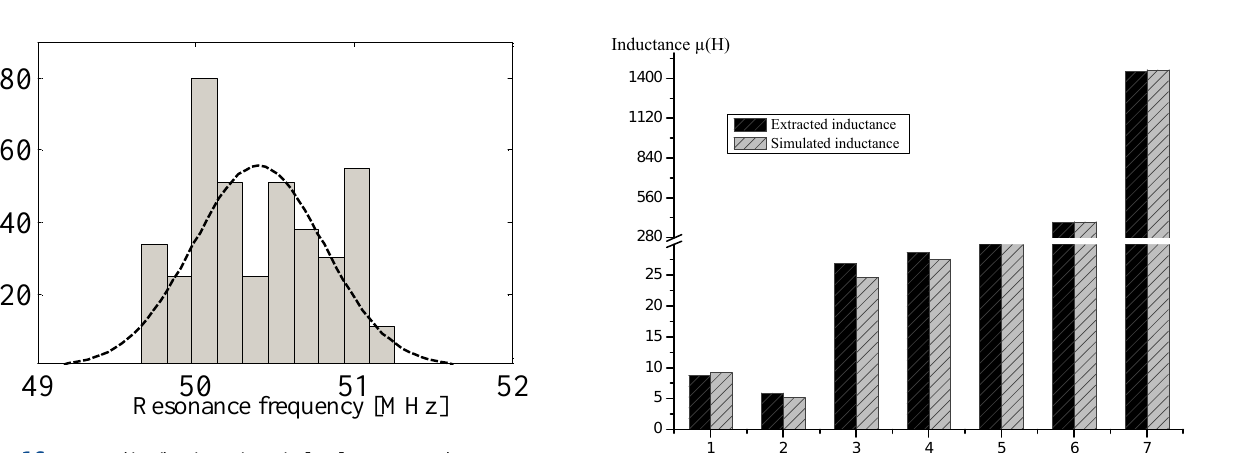
Figure 16. Error distributions in wirelessly measured resonance frequency of a micro coil with 33 turns measured at the center of loop antenna in presence of another test micro coil with 60 turns. The mean resonance frequency of the 33-turn micro coil is shifted to 50.12MHz. The dotted line represents the Gaussian distribution of the corresponding moments.